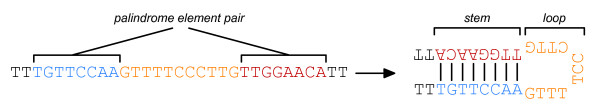
Identification of a palindrome element pair that could potentially produce stem loop interference. The stem consists of (3 × 3) + (5 × 2) = 19 hydrogen bonds and the loop has a circumference of 11 bases.